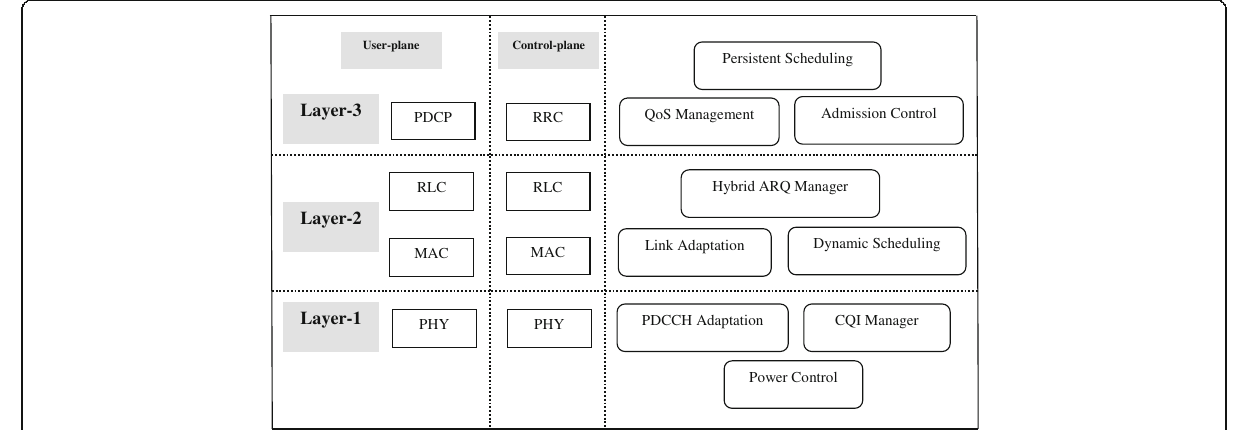
Fig. 3 Radio resource management in LTE control and user plane protocol